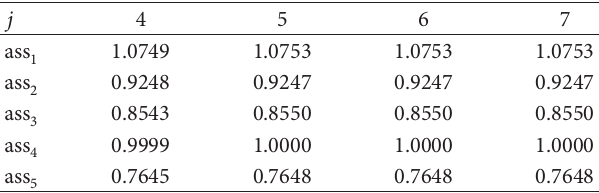
Table 1: Assumptions check for Example 15 with different values of 𝑗